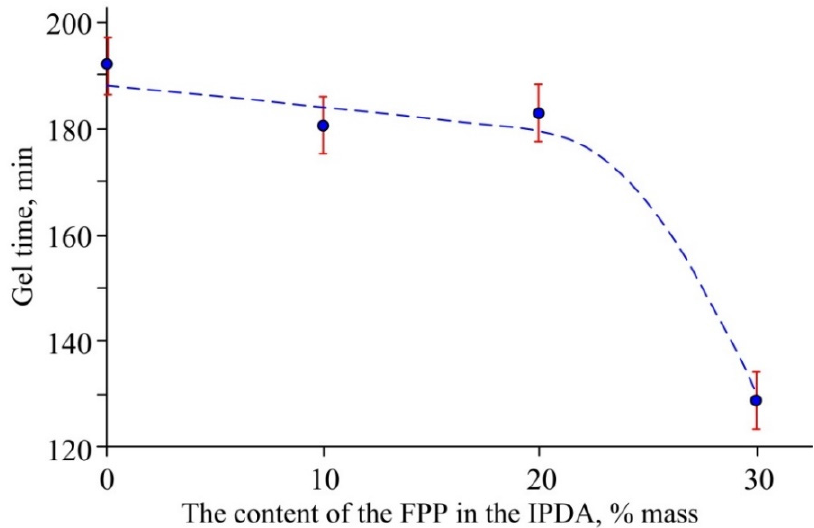
Figure 4. The gel time of the compositions vs. the FPP content in IPDA.